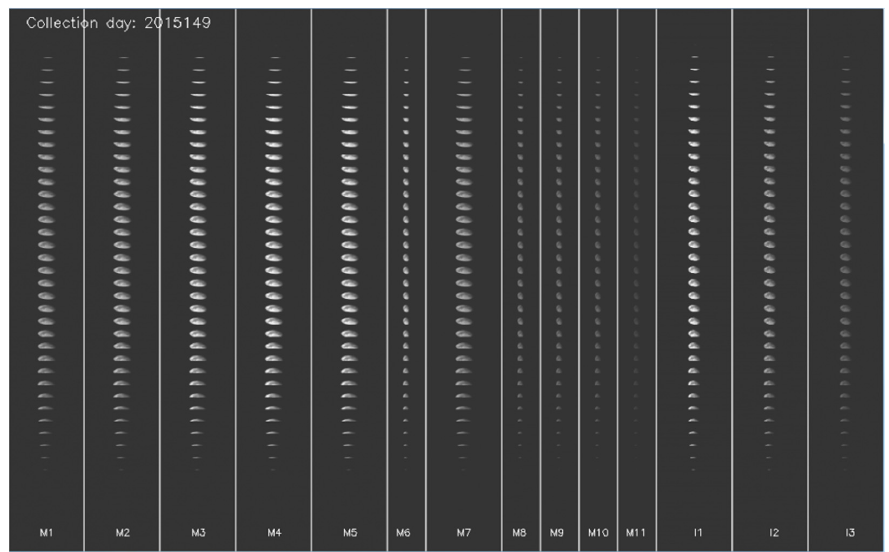
Figure 5. Scheduled lunar data collection for VIIRS on 29 May 2015.